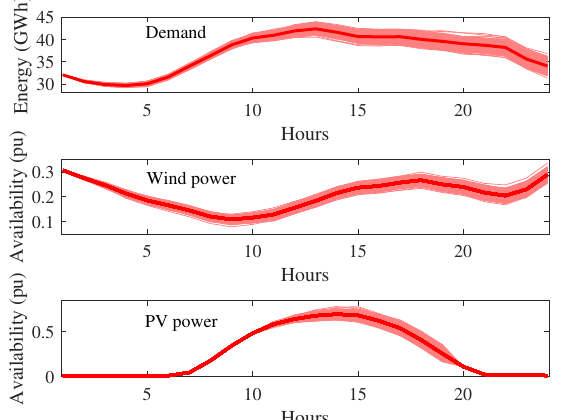
Figure 3. Demand, wind and PV availability scenarios for 5th of July of 2017.